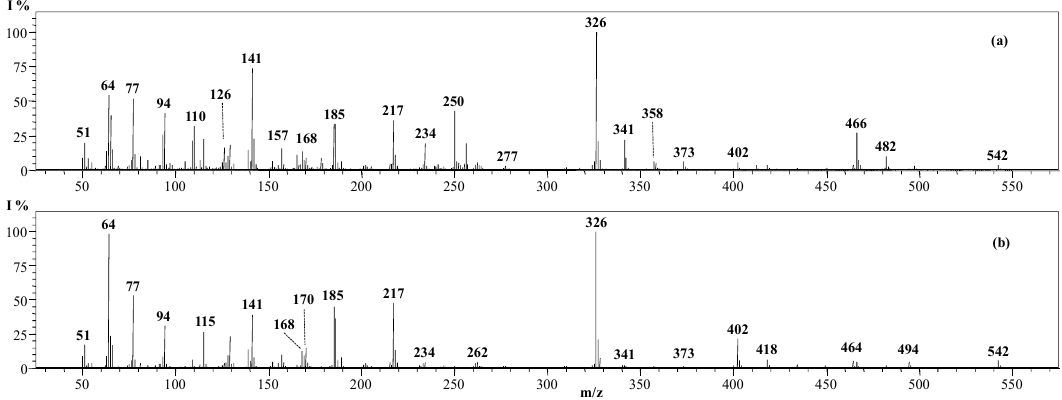
Figure 4. EI-DPMS spectra of the P(ESES) sample recorded in the temperature ranges ( a ) 430–480 °C and ( b ) 480–500 °C.